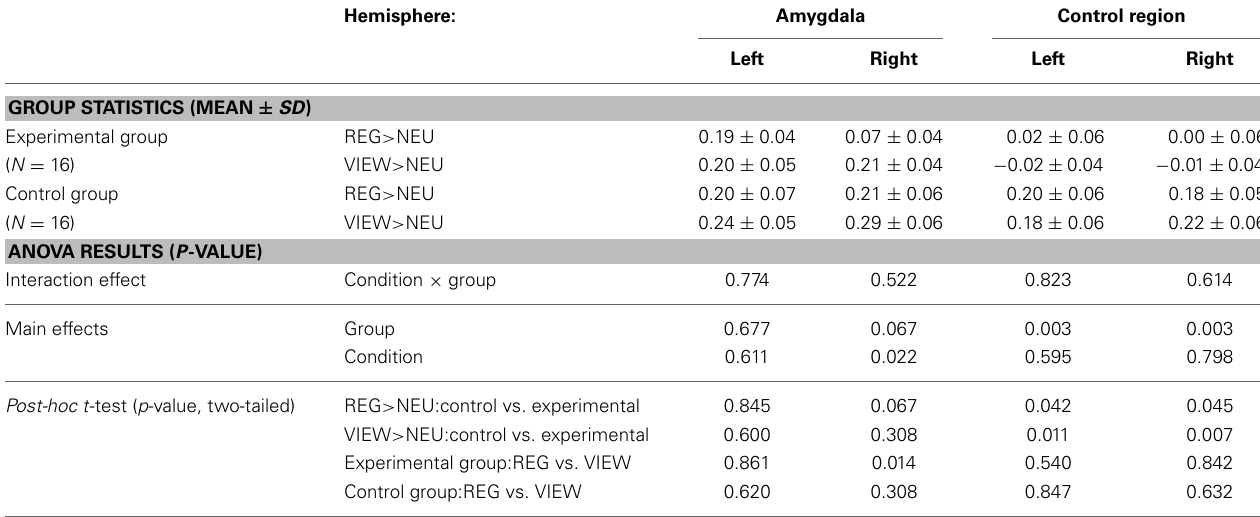
Table shows parameter-estimate-contrast values from the regions of interest. SD, standard deviation; REG, regulate; NEU,